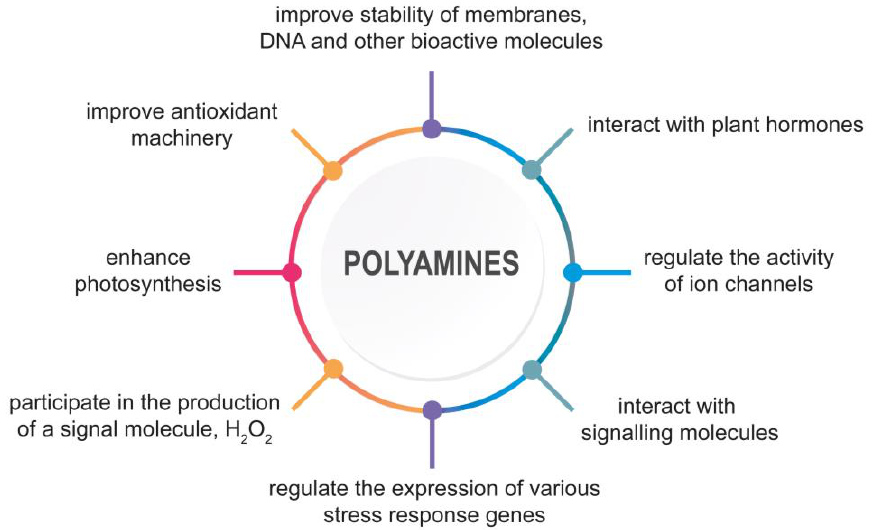
Figure 1. The multitrack action of PAs in plant response and tolerance to abiotic stresses.